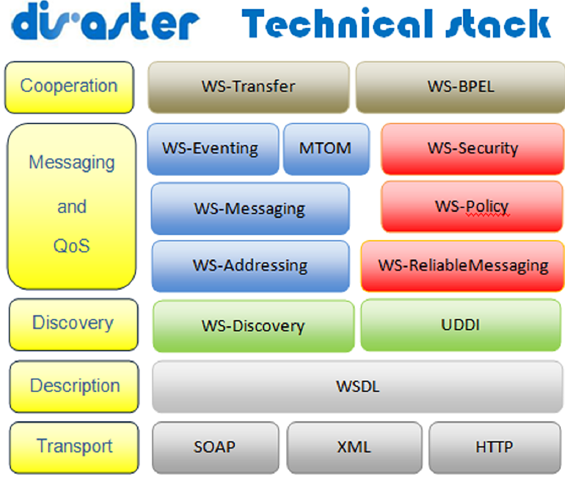
Figure 5. DISASTER technical stack. The bottom level is transport, which refers to the message format and protocols used to exchange the information. Description level includes the standards to describe both functional and non-functional characteristics of the services. Discovery level refers to the standards used to publish and organize the services included in the DISASTER solution. Messaging level refers to the mechanism provided to ensure that messages are cor- rectly delivered. Cooperation level deals with the composition and coordination between multiple service operations when